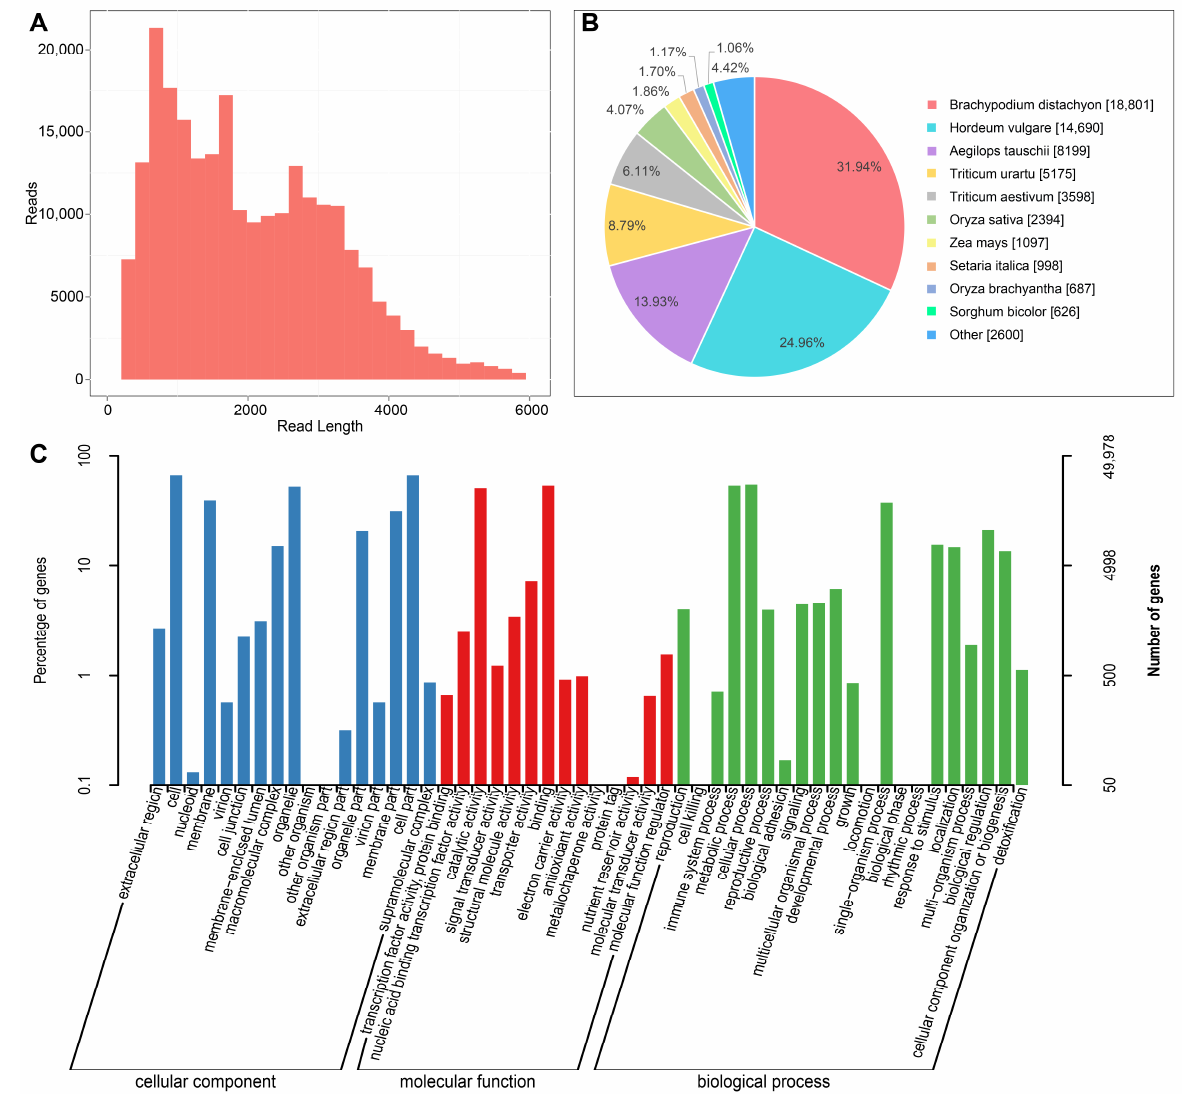
Figure 2. Construction of oat full-length transcriptome through PacBio sequencing. ( A ) CCS read length distributions. ( B ) Homologous species distribution of oat annotated in the Nr database. ( C ) GO functional classification of transcripts. Table 1. Summary of PacBio sequencing data in